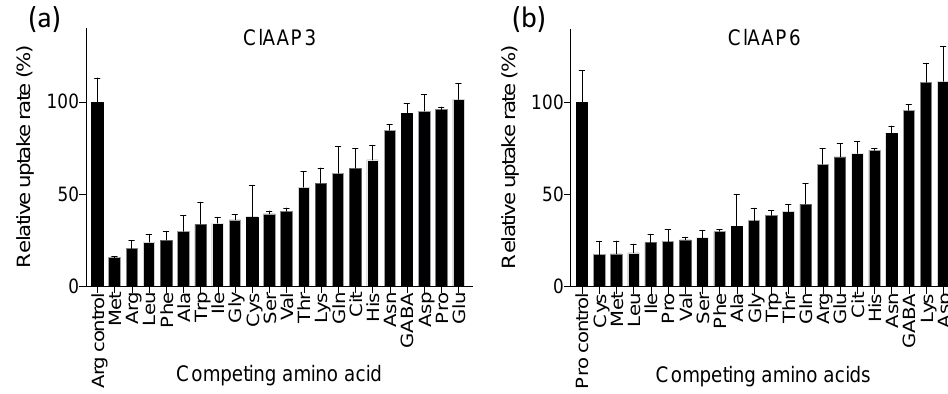
Figure 5. E ff ects of competing amino acids to ClAAP3 and ClAAP6 mediated amino acid uptake. ( a ) E ff ects of competing amino acids on [ 3 H]-Arg uptake by ClAAP3. ( b ) E ff ects of competing amino acids on [ 3 H]-Pro uptake by ClAAP6. In both experiments, [ 3 H]- labeled amino acids were supplied at 1 mM concentration, whereas the competing unlabeled amino acids were supplied at five-fold concentrations (i.e., 5 mM). The values are expressed as % of cells that did not receive any competing amino acids. Error bars represent standard deviation ( n = 3).